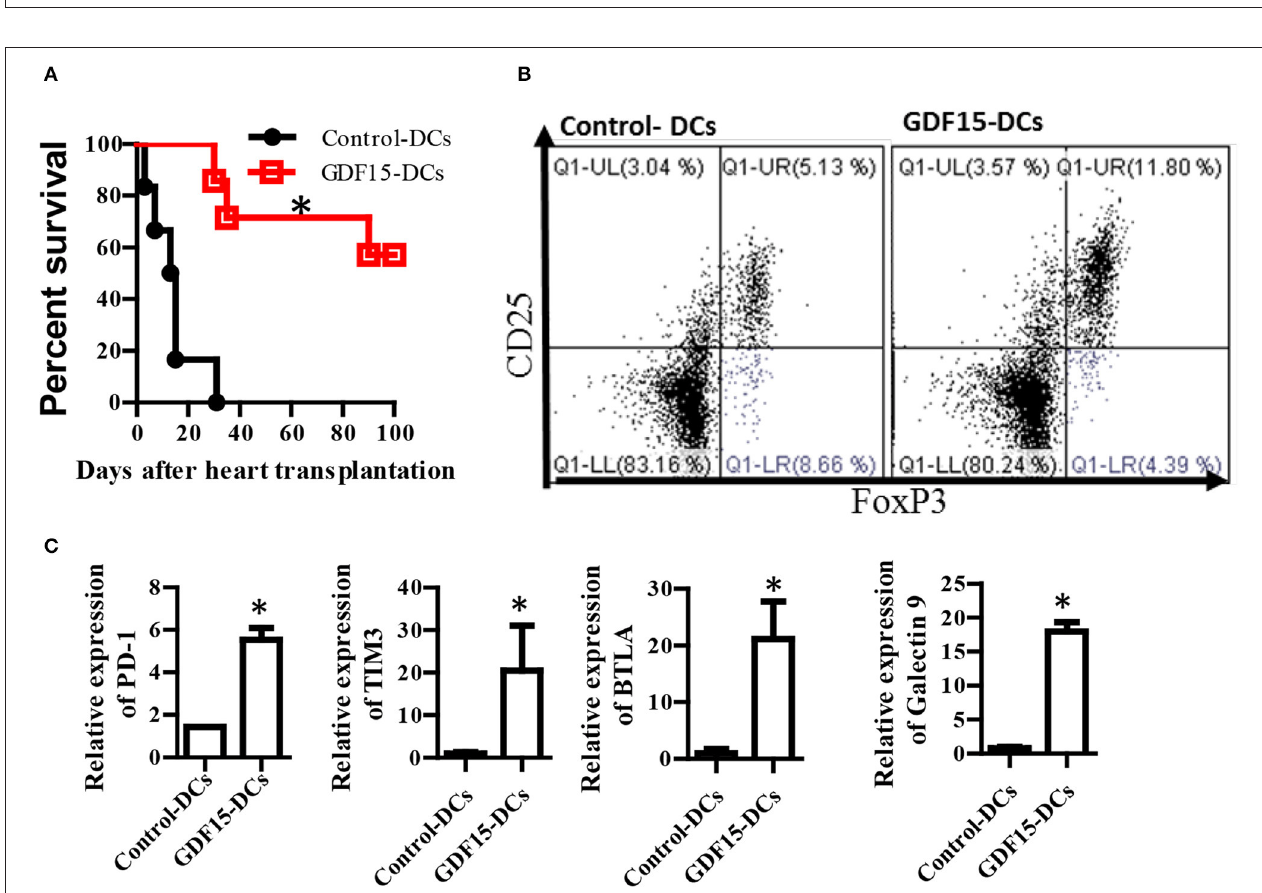
FIGURE 7 | GDF15 regulated DCs prevent allograft rejection in heart transplantation and augment tolerance induction and T cell exhaustion. (A) Allograft survival. Donor derived (C57BL/6) DCs were cultured and treated with GDF15-Ad or Null-Ad on day 2. 1 million day 7 DCs were i.v. injected into recipient BABL/c mice 7 days prior to heart transplantation. Allogeneic heart transplantation was conducted between C57BL/6 and BABL/c mice. Recipient mice daily received 1 g/kg rapamycin for 7 days from day 0 post transplantation. The cessation of heartbeat was defined as rejection. n = 6. (B) CD4 + CD25 + Foxp3 + Tregs in splenic cells. At the end of experiments, mice splenic cells were isolated from recipient mice on day 100 to detect CD4 + CD25 + Foxp3 + Tregs by flow cytometry. Representative images (upper) and relative quantity of FoxP3 protein from n = 3 * P < 0.05. (C) Inhibitory receptor expression. RNA was extracted from the above rejected and tolerant recipient mice. Gene expression of inhibitory receptors PD-1, TIM3, BTLA and galectin 9 was detected by qRT-PCR. n = 3, the student t -test was conducted for statistical analysis * P <